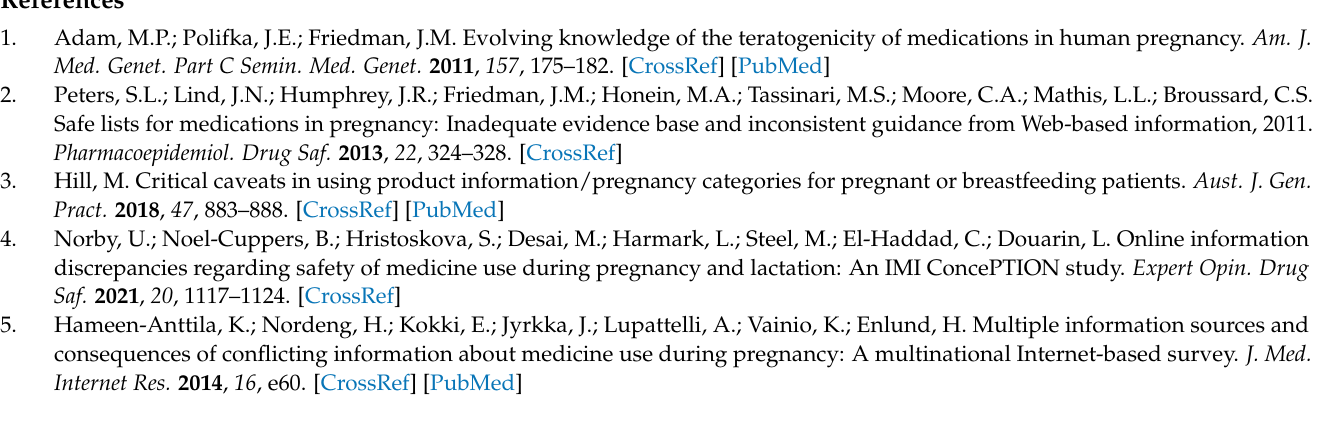
Table S14: Preferences of HCPs regarding the timing to contact the future Teratology Information Service in Belgium in case of specific (non-urgent) questions on medication use during pregnancy or breastfeeding; Table S15: Preferences of HCPs towards the acceptable ‘waiting’ time when contacting the future Teratology Information Service in